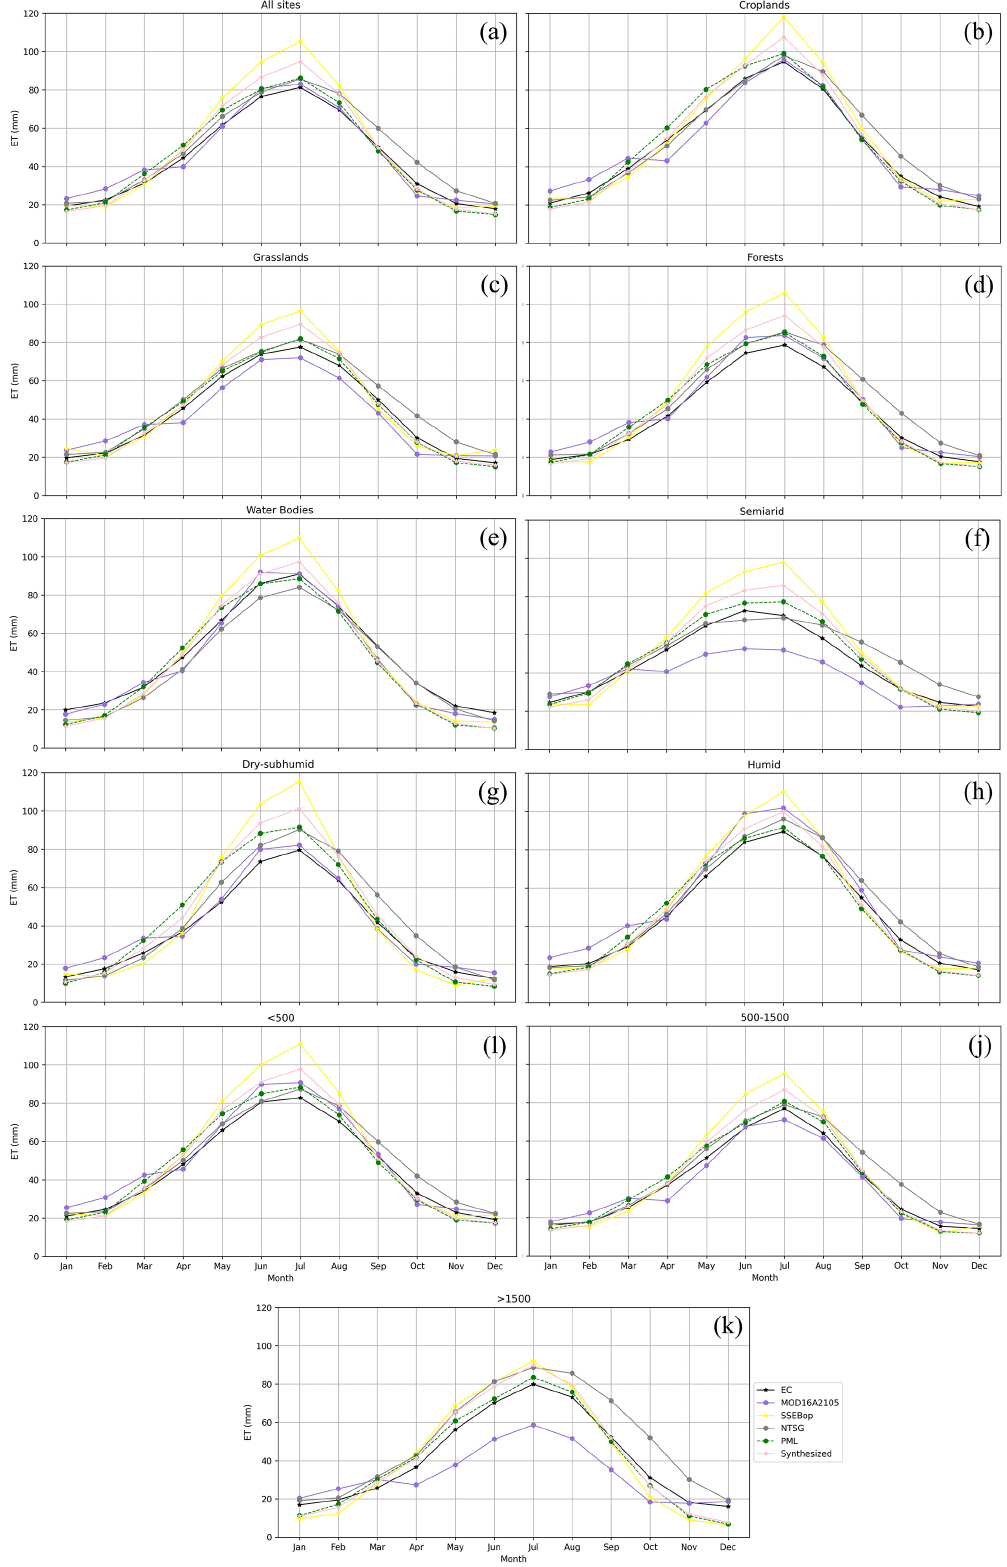
Figure 13. Monthly average flux EC ET, MOD16A2105, SSEBop, NTSG, PML, and the synthesized ET (subplot labels as in Fig. 3).